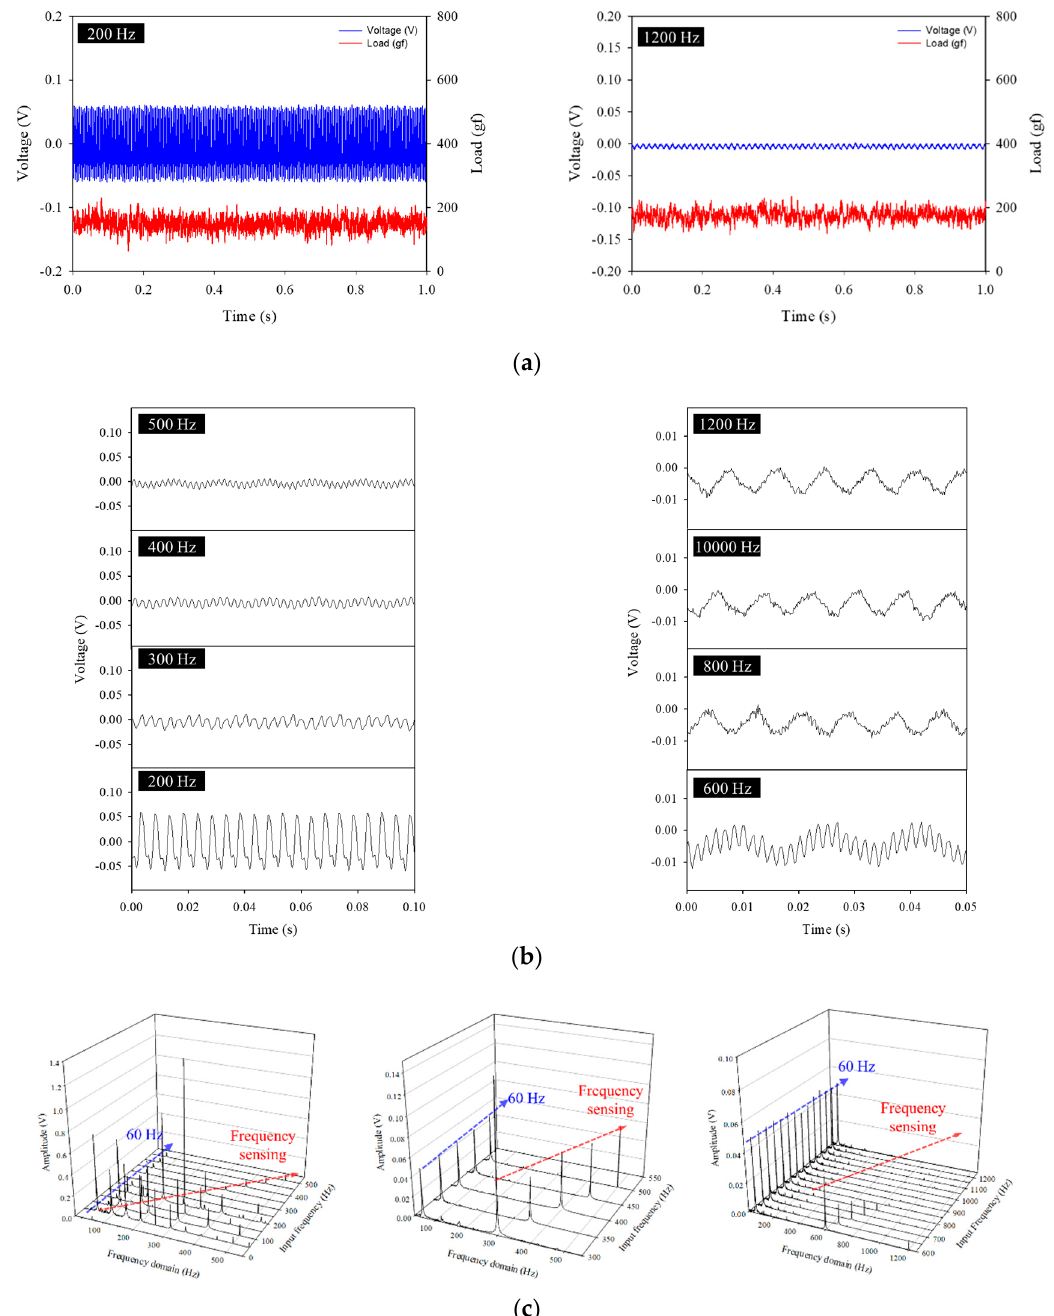
Figure 7. ( a ) Output voltages and loads for 200 and 1200 Hz. ( b ) Output voltages by mechanical forces applied to the flexible piezoelectric device according to high frequencies at a load of 200 gf. ( c ) FFT matching according to high − frequency inputs.